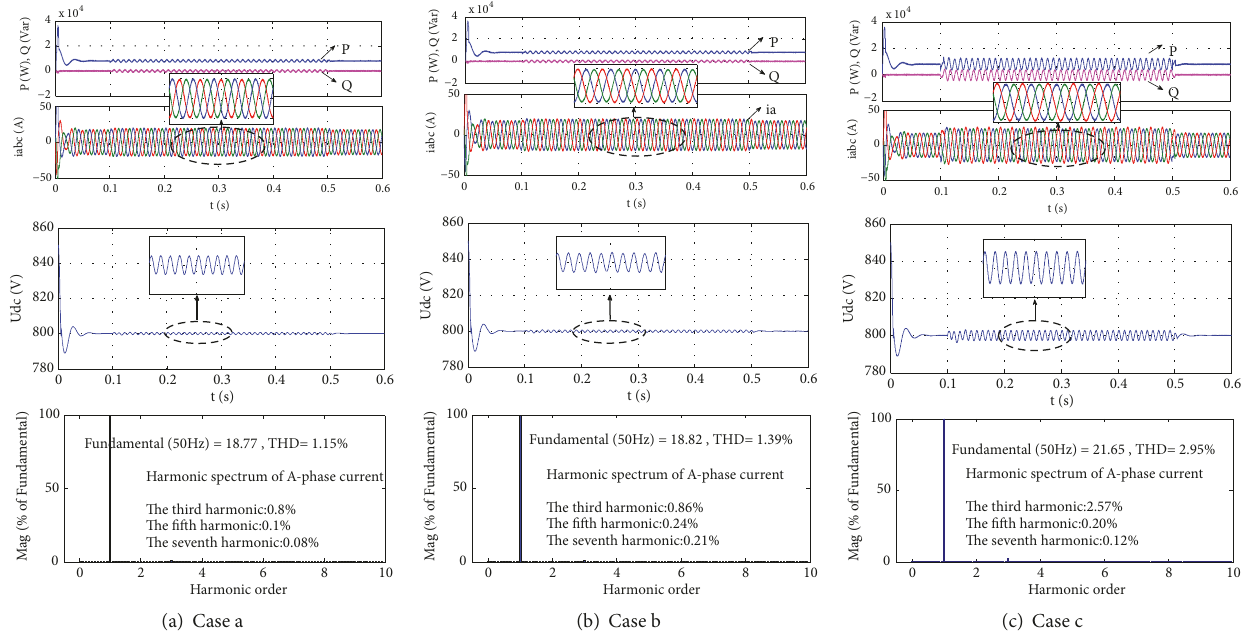
Figure 13: Simulation results of current balance control strategy in different